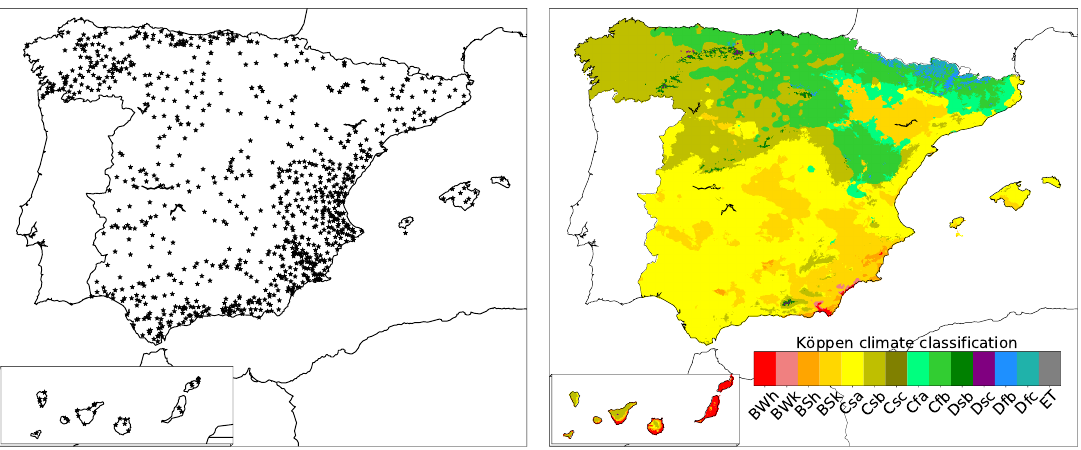
Figure 1. (Left) Location of the hourly (735, black stars) rainfall gauges used in the present study with rainfall records in the period 1990–2015. (Right) Spatial distribution of Köppen–Geiger climate groups developed by AEMET [32]. The acronyms shown in the legend correspond to the following climatic subgroups: BWh (hot desert), BWk (cold desert), Bsh (hot semi-arid), Bsk (cold semi-arid), Csa (temperate hot-summer), Csb (temperate warm-summer), Csc (temperate cold-summer), Csa (temperate humid subtropical), Cfb (temperate oceanic climate), Dsb (Mediterranean-influenced hot-summer humid continental), Dsc and Dfc (Subarctic climates), Dfb (Warm-summer humid continental climate), and ET (tundra